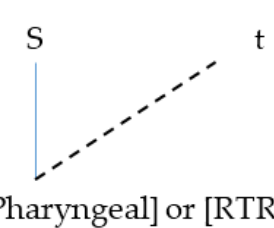
Figure 3. Emphasis spread to the infix /t/.